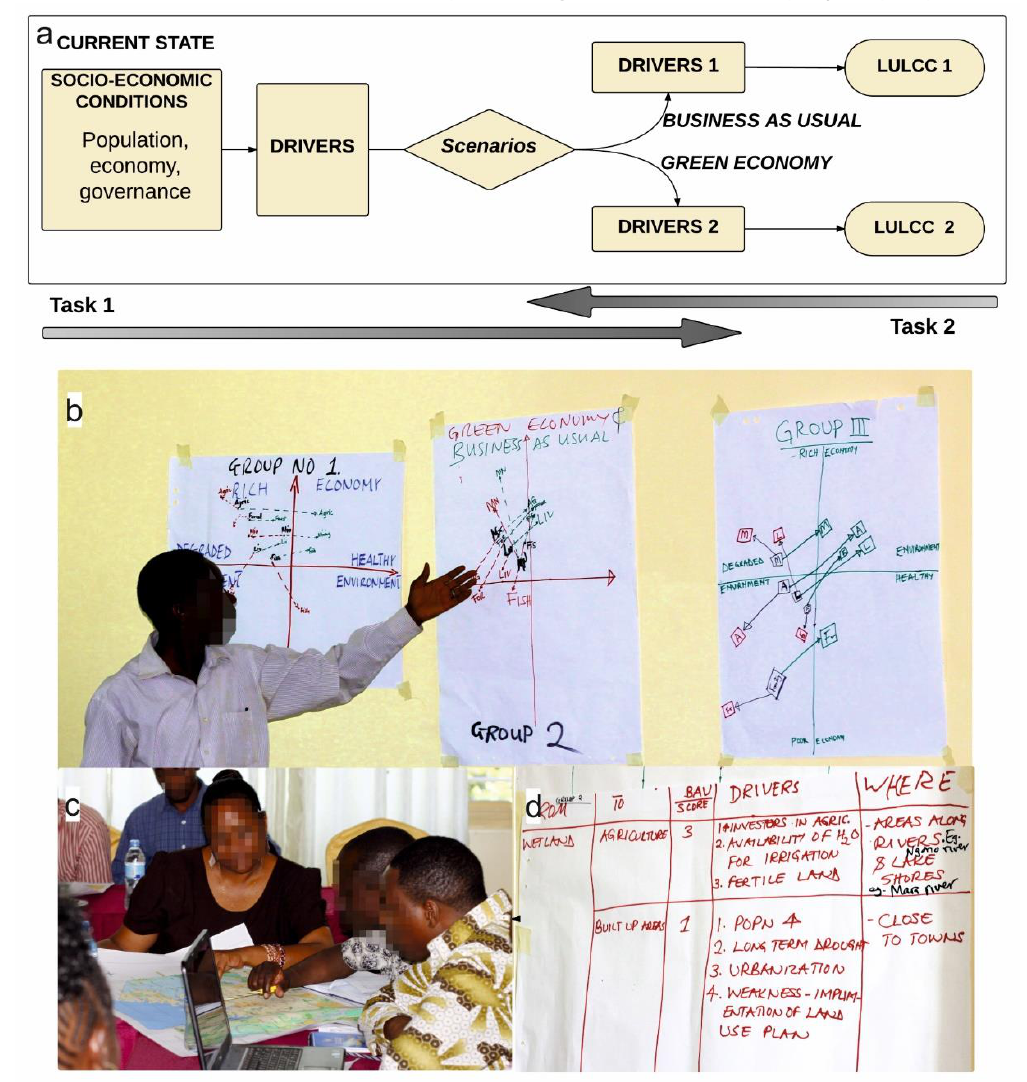
Figure A1.1. Stakeholder-driven scenario development logic flow (a) and step by step representation